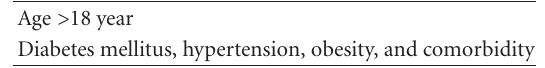
Table 1: Exclusion